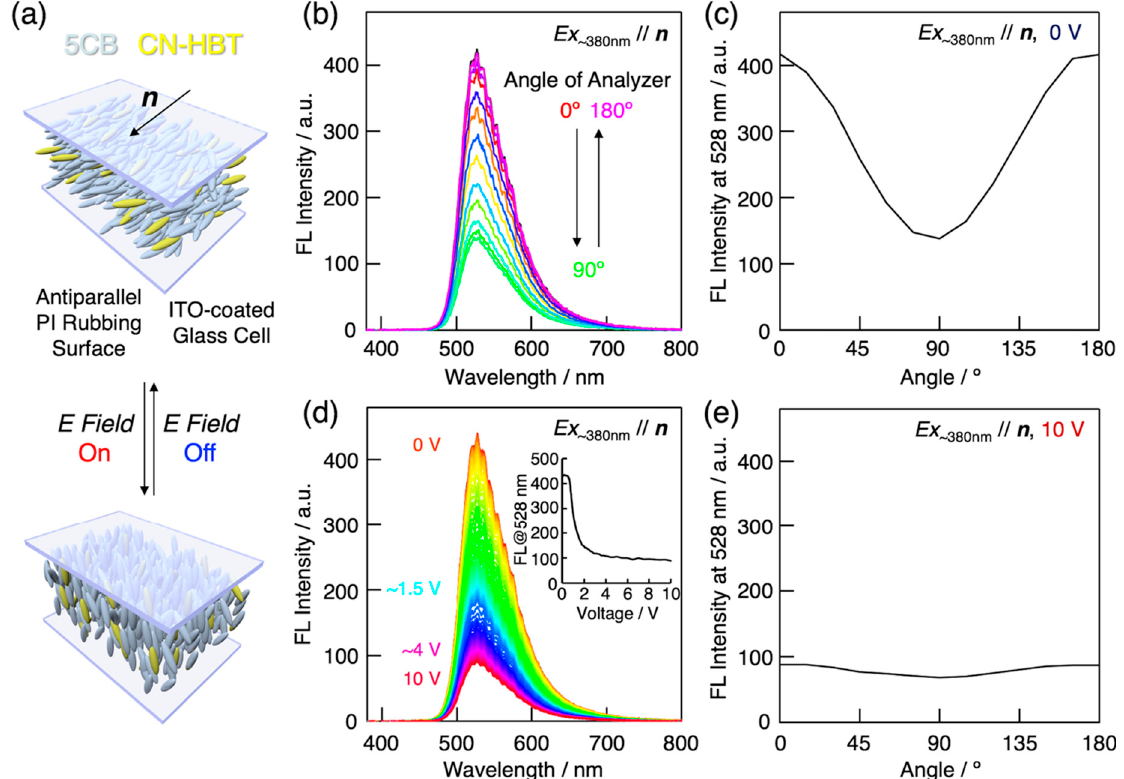
Figure 6. ( a ) Schematic illustrations of 5CB/CN-HBT host–guest LCs in sandwiched ITO-glass cell with surface polyimide (PI) rubbing in antiparallel directions. Gray- and yellow-colored rod-shaped objects represent 5CB and CN-HBT molecules, respectively. The LC director ( n ) orients along the rubbing axis at zero field and reorients to become perpendicular to the substrates when the electric field is applied. ( b ) Analyzer angle dependence of the fluorescence spectrum of 5CB/CN-HBT (99/1 wt/wt) in a 15- µ m thick antiparallel PI rubbing LC cell. The excitation light ( λ Ex = 385 nm) is polarized parallel to the rubbing axis (i.e., n ) and the analyzer angle is measured from the rubbing axis. ( c ) Polarization dependence of fluorescence intensity at 528 nm in ( a ). ( d ) Applied voltage dependence of the fluorescence spectrum of 5CB/CN-HBT (99/1 wt/wt). Inset represents fluorescence intensity at 528 nm as function of applied voltage. ( e ) Polarization dependence of fluorescence intensity at 528 nm and applied voltage of 10 V.